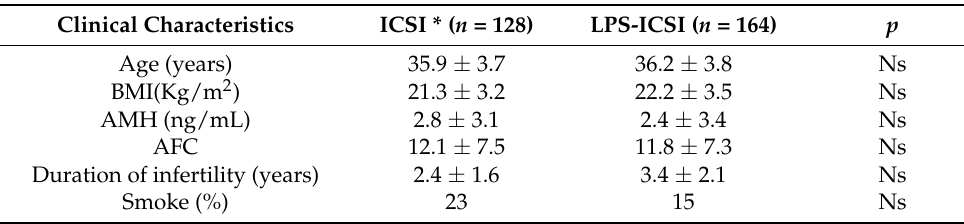
Table 3. Clinical characteristics of patients who underwent ICSI in the presence of endometrioma ICSI ( n = 128) or were previously operated on by having their endometrioma laparoscopically removed before ICSI ( n = 165). No statistically significant difference in the baseline clinical features was observed between groups.